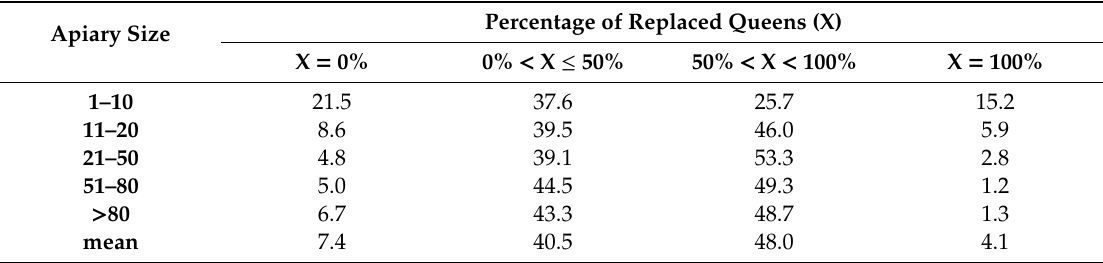
Table 3. Percentage of queens replaced by beekeepers, analyzed by apiary size and calculated on the basis of the data from 1980 to